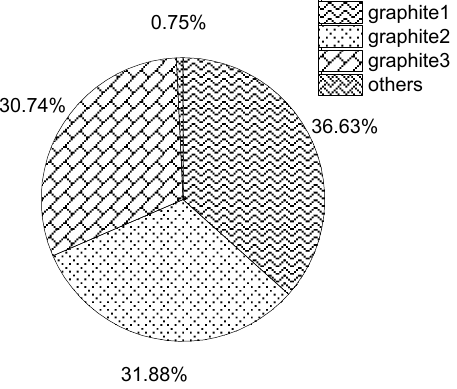
Figure 21. Wear depth percentage.